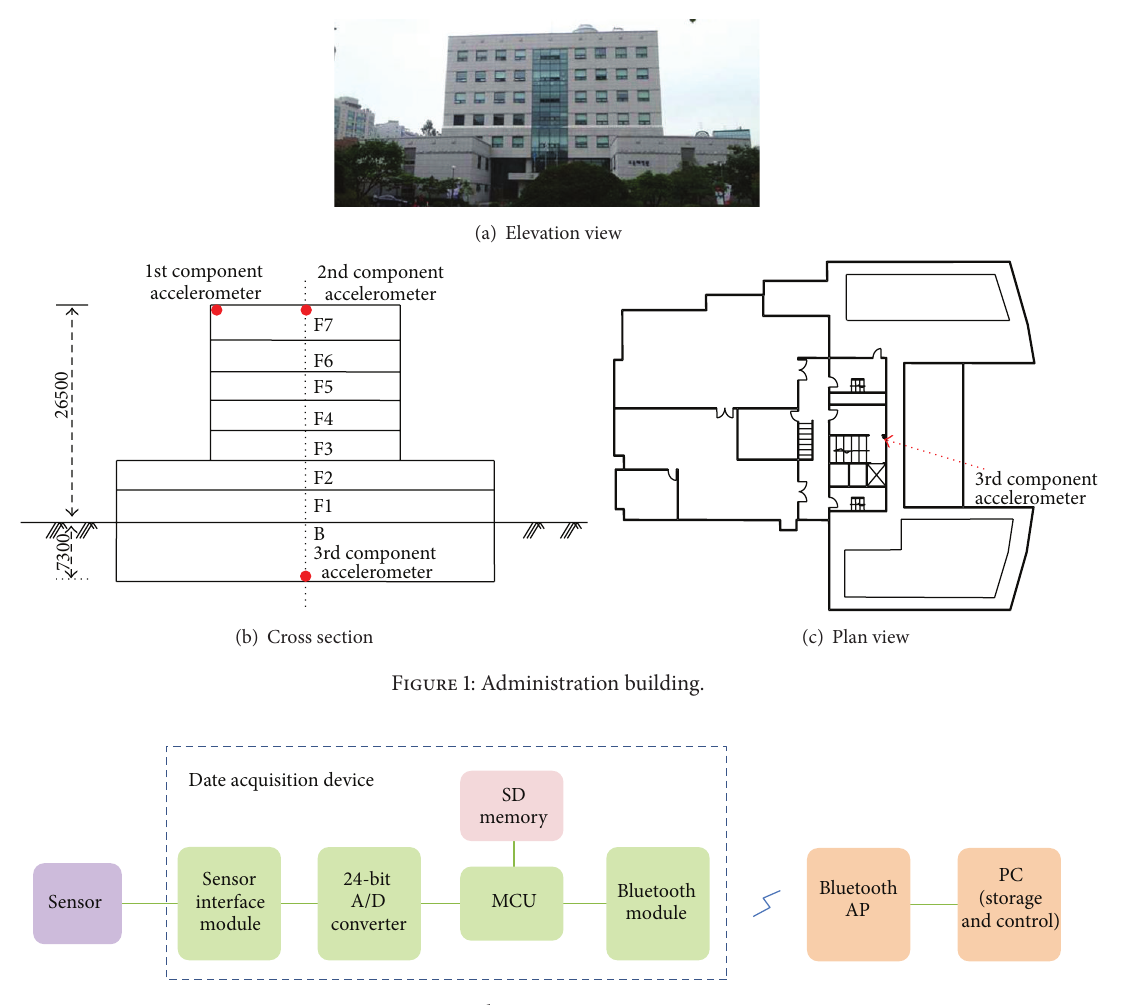
Figure 2: Structural monitoring system components.